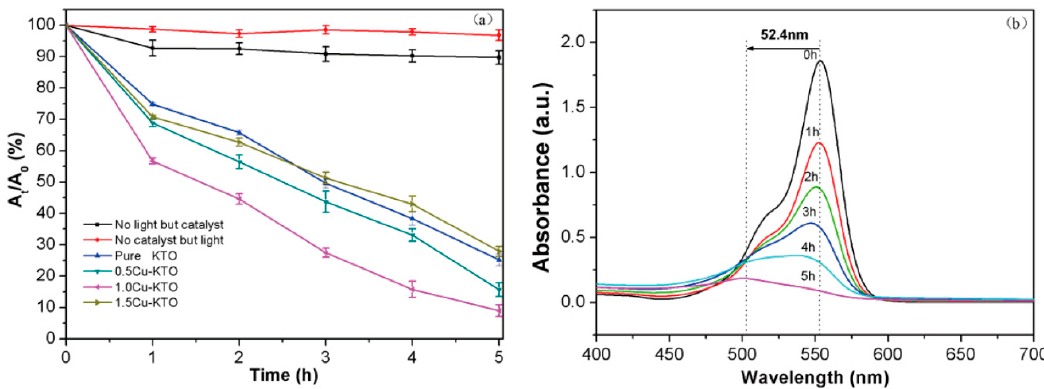
Figure 6. Degradation rate of RhB in different conditions with respect to time ( a ) and UV–Vis absorption spectra of RhB using 1.0 Cu–KTO as the photocatalyst under simulated sunlight irradiation ( b ).